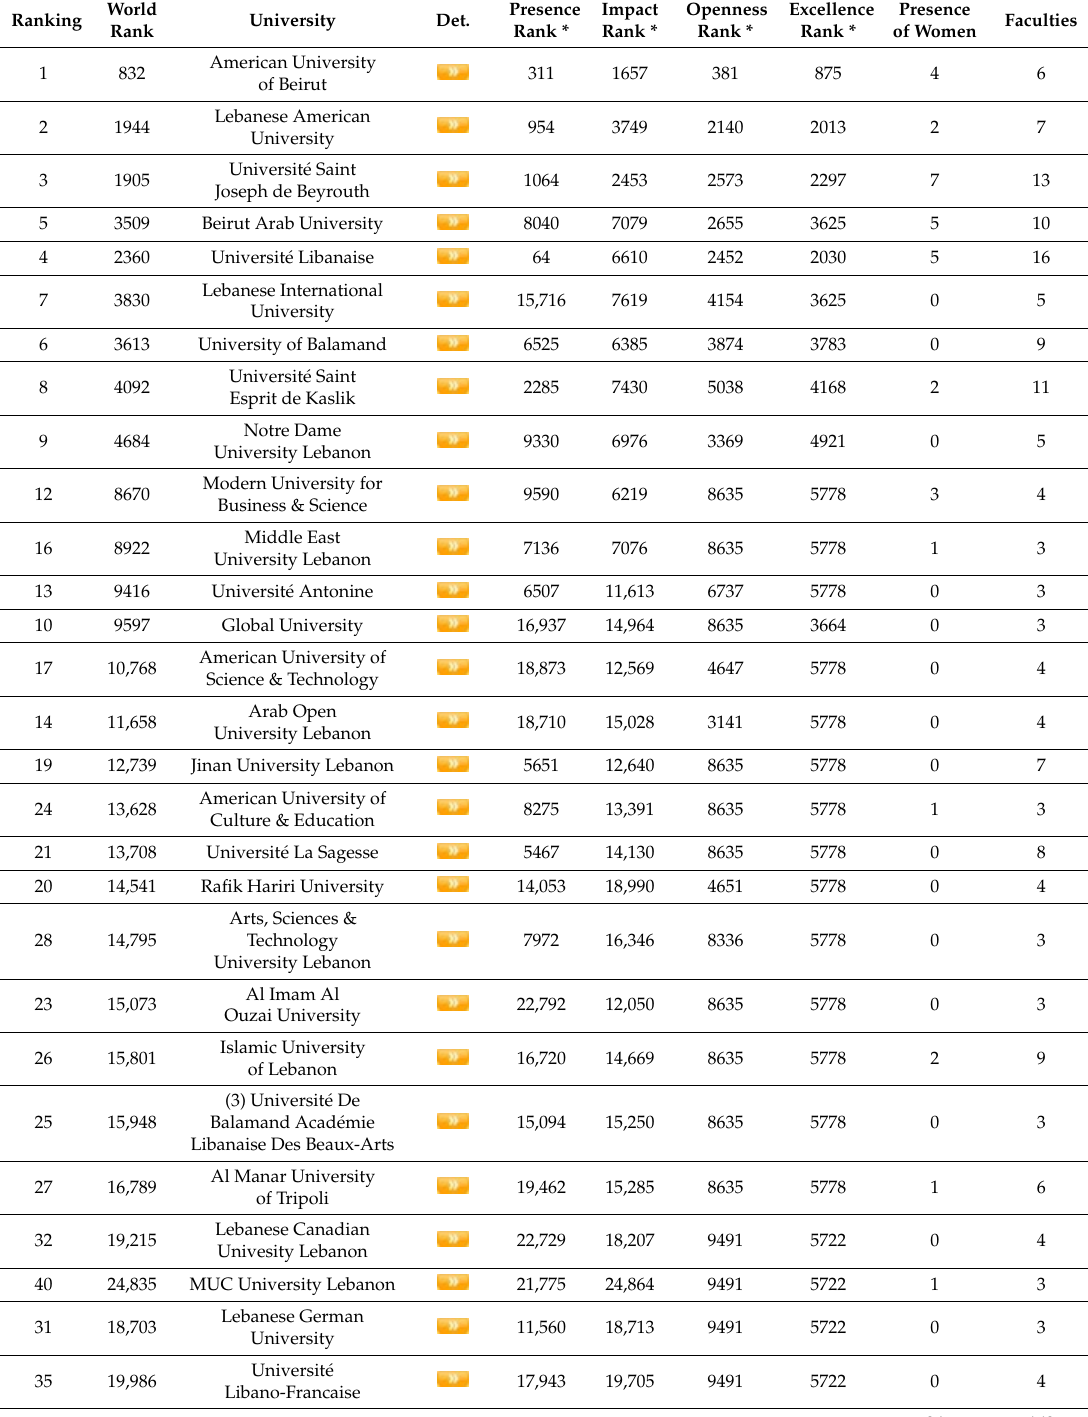
Table 1. Webometrics Ranking/Women Presence.